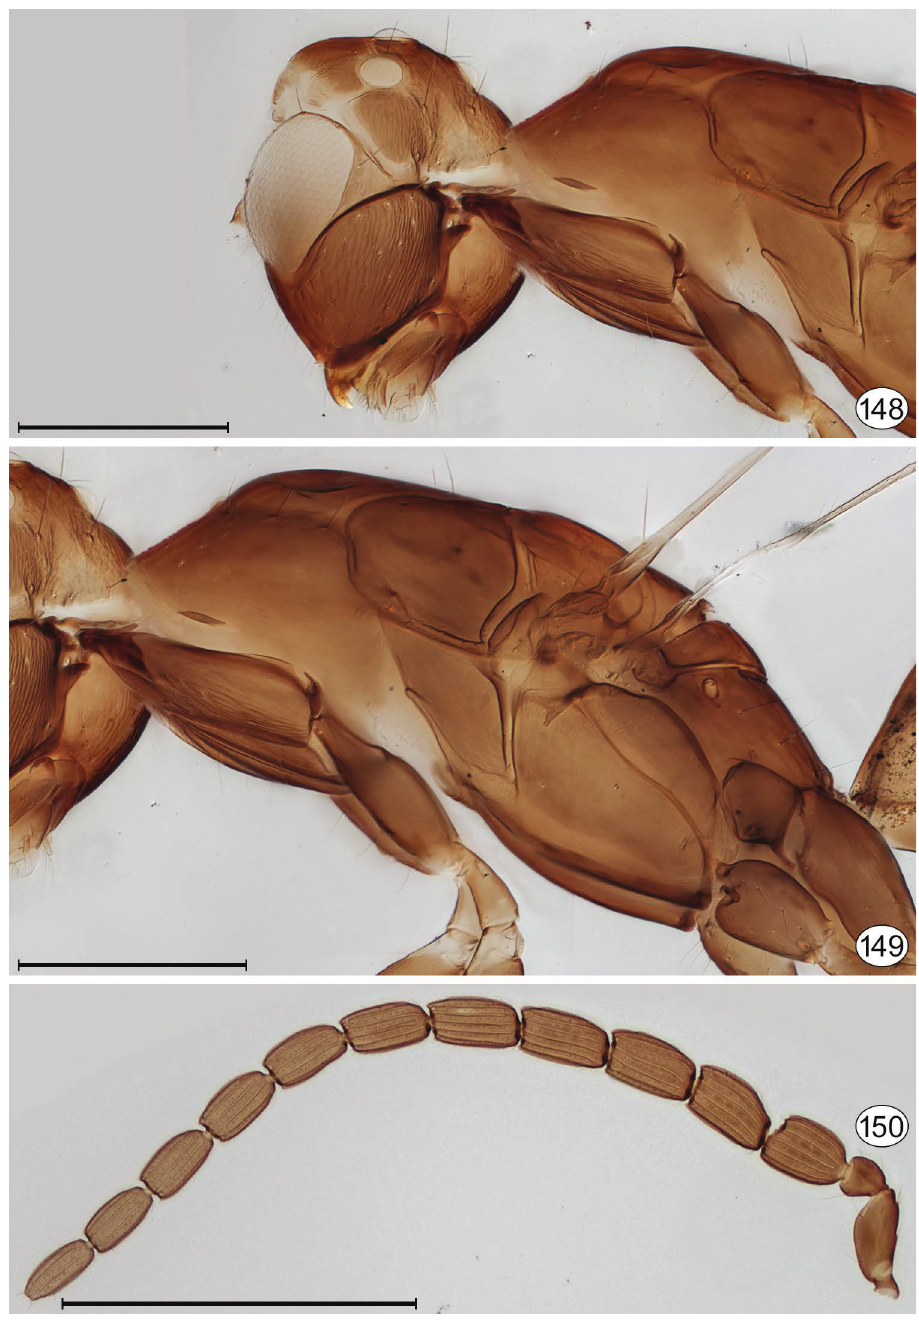
Figures 148–150. Neotriadomerus sp. 4, male (Australia, NT, 12 km WNW Ross River, Tourist Camp). 148 head and anterior mesosoma, lateral 149 mesosoma, lateral 150 antenna. Scale bar for 148, 149 = 200 μm; 150 = 400